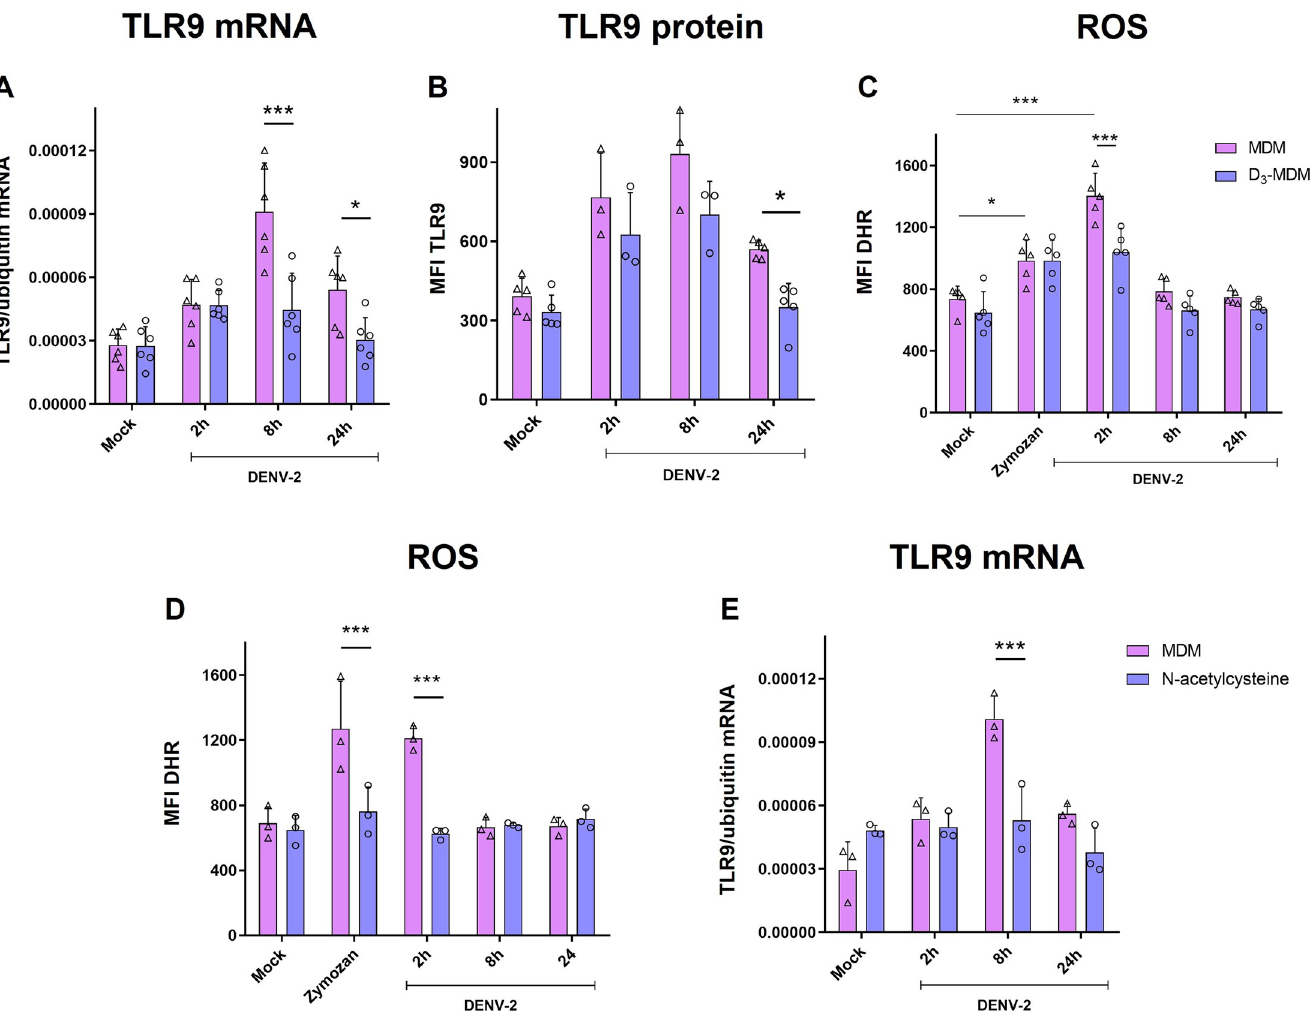
Fig 4. VitD3 downregulates TLR9 expression and ROS production in D 3 -MDMs. MDMs were differentiated in the presence of VitD3 (0.1 nM) for 6 days (D 3 - MDMs) and then infected with DENV-2 with an MOI of 5 for 2, 8, or 24 h. Expression of TLR9 (A) was measured by qPCR in MDMs and D 3 -MDMs using the gene encoding ubiquitin as a housekeeper gene. Data are expressed as fold change relative to mock-treated MDMs and D 3 -MDMs from each time point. Expression at the protein level of TLR9 (B) was measured by flow cytometry and expressed as mean fluorescence intensity. The production of ROS was measured by flow cytometry through DHR 123 in MDMs and D 3 -MDMs infected with DENV-2 with an MOI of 5 for 2, 8, and 24 h, or stimulated with 10 μ g/mL of zymosan (C). The MDMs were pre-treated with N-acetylcysteine at 10 mM for 1 h and then infected with DENV-2 with an MOI of 5 for 2, 8, and 24 h or treated with 10 μ g/mL of zymosan. Production of ROS was measured by flow cytometry through DHR 123) (D) and the TLR9 expression was measured by qPCR (E). Six different donors (A, B, and C) or three different donors (D and E) were analyzed. Differences were obtained with a two-way ANOVA with a Bonferroni posthoc test and a 95% confidence interval ( ��� p < 0.001, �� p < 0.01, � p <